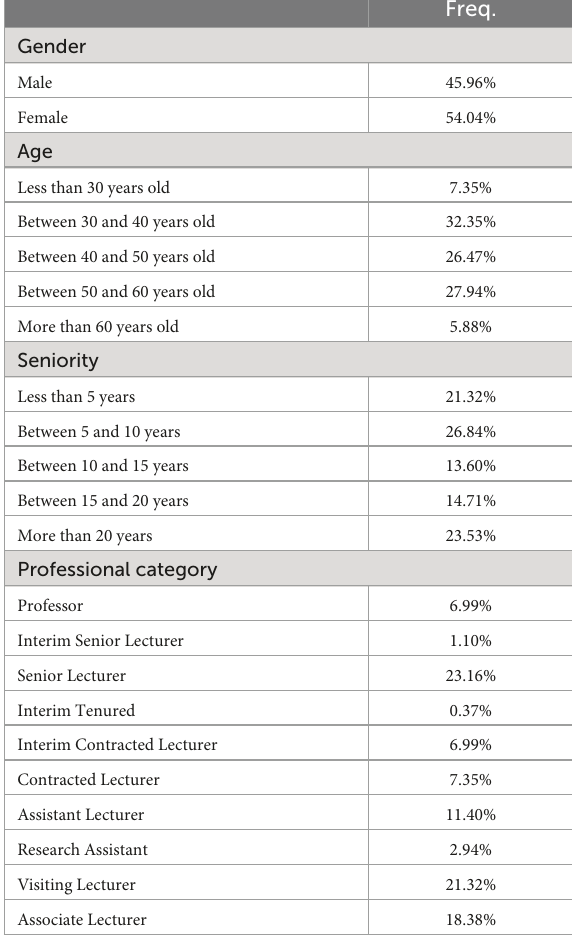
TABLE 3 Comparison with the difference of means of variable Self-Esteem according to control variables. Freq. Mean F welch